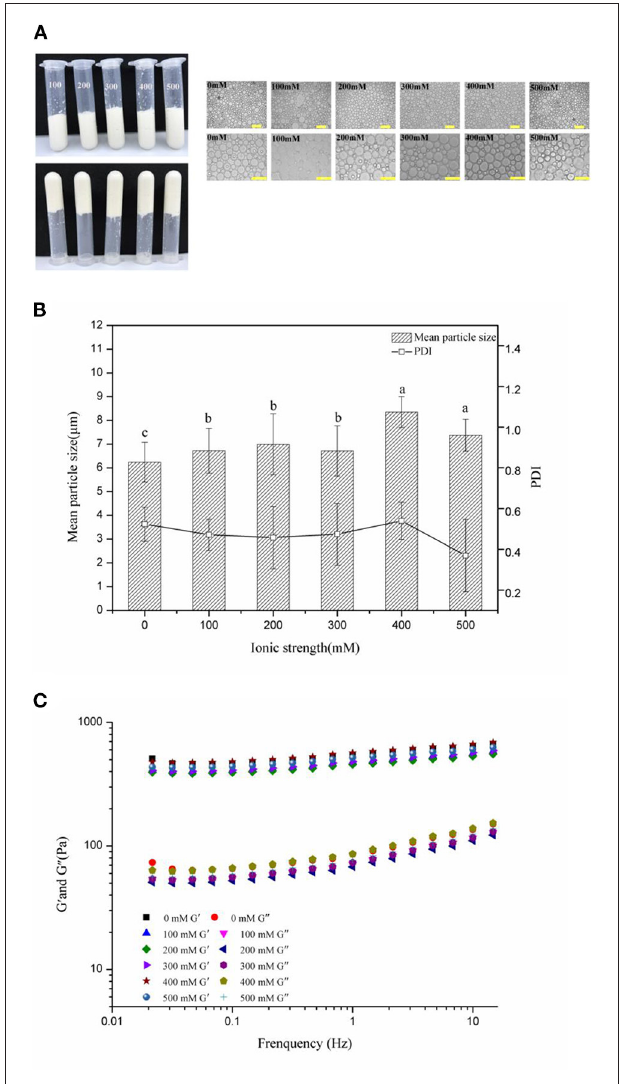
FIGURE 5 | Visual appearance and optical micrographs (A) , mean particle sizes and PDI (B) , frequency sweeps (C) of the WSP-stabilized HIPEs at different salt concentrations. Different letters (a, b, c) in the same column indicate significant differences ( p <